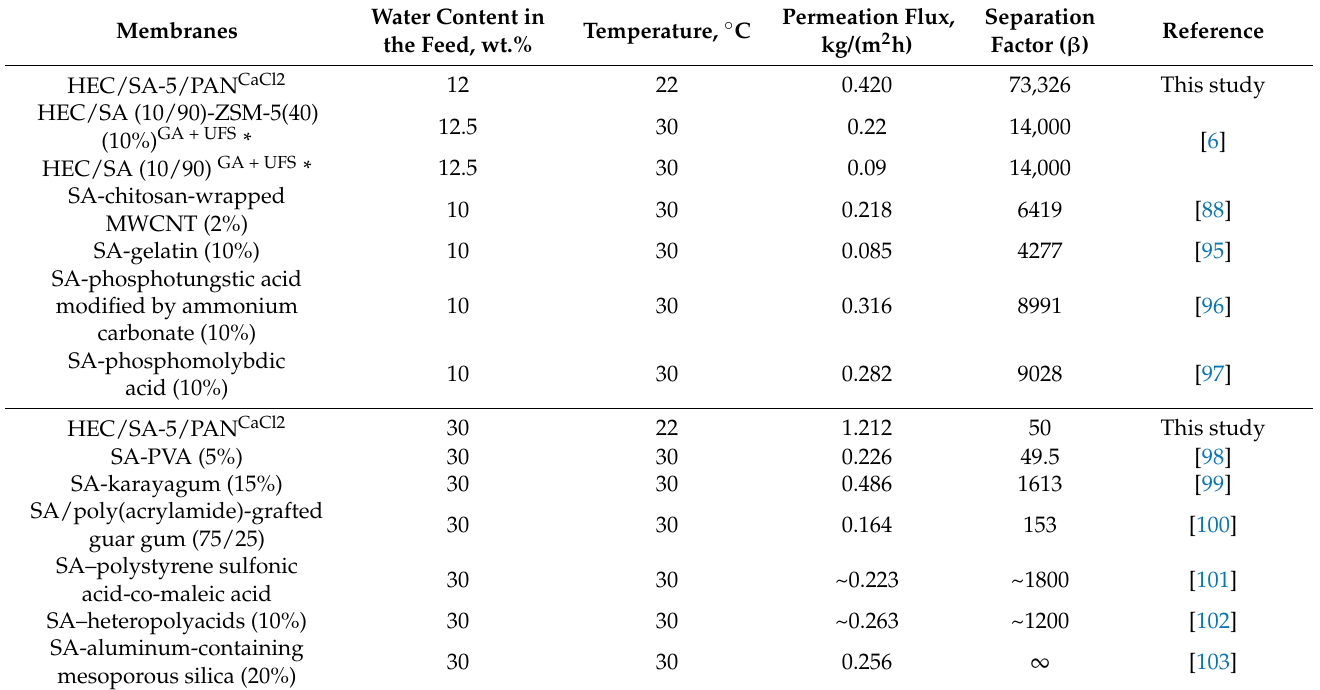
Table 8. The comparison of the transport properties of the SA-based membranes in pervaporation dehydration of iso-